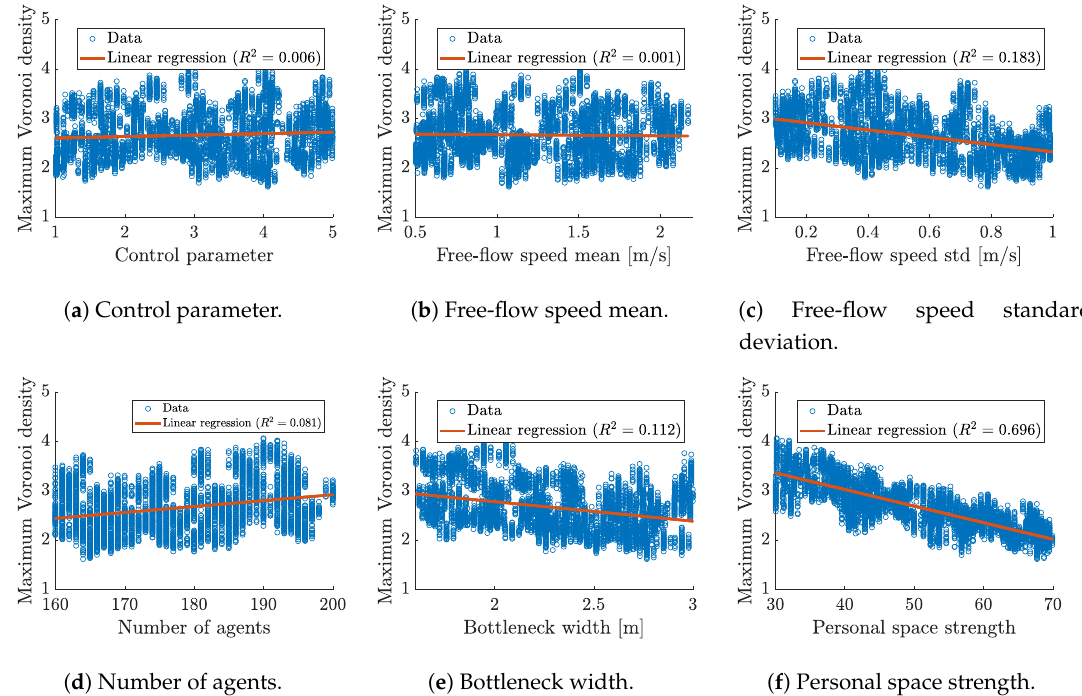
Figure 5. Scatterplot of input-output relation for each input parameter. We use the model evaluations from the derivative-based method. Each run is shown, that means 10 data points for each configuration. In total, 81 gradient samples are evaluated which leads to a total of 9720